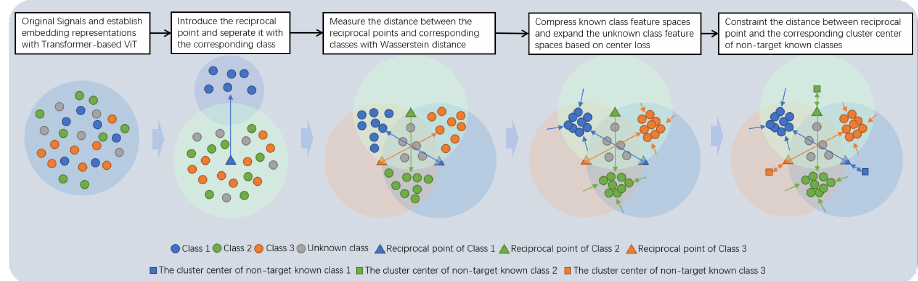
Figure 1. Main algorithm framework containing three key sub-modules: the signal representation sub-module based on tansformer-based ViT structure; the set distance metric sub-module based on Wasserstein distance; abd the class space compression sub-module based on reciprocal point separation and central